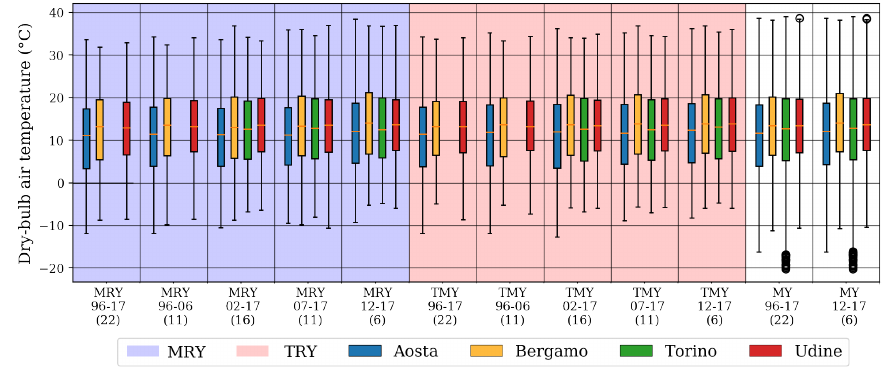
Figure 7. Box-plot of the dry-bulb air temperature for the generated years. Lower and upper box boundaries are the 25th and the 75th percentile, respectively, the line inside the box is the median, the lower and the upper error lines are the 10th and the 90th percentiles, respectively, the data falling outside the 90th and the 10th percentiles are represented by circles. The background is blue for the Moisture Representative Years (MRY) and red for the Typical Meteorological Years (TMY). The MY bars (white background) are the values of the multi-year of respectively 22 (total weather record) and 6 years (last years of the weather record). The multi-year of Torino is calculated with 16 years and the lower values are due to the extremely cold winter of 2012 that was less extreme in the other